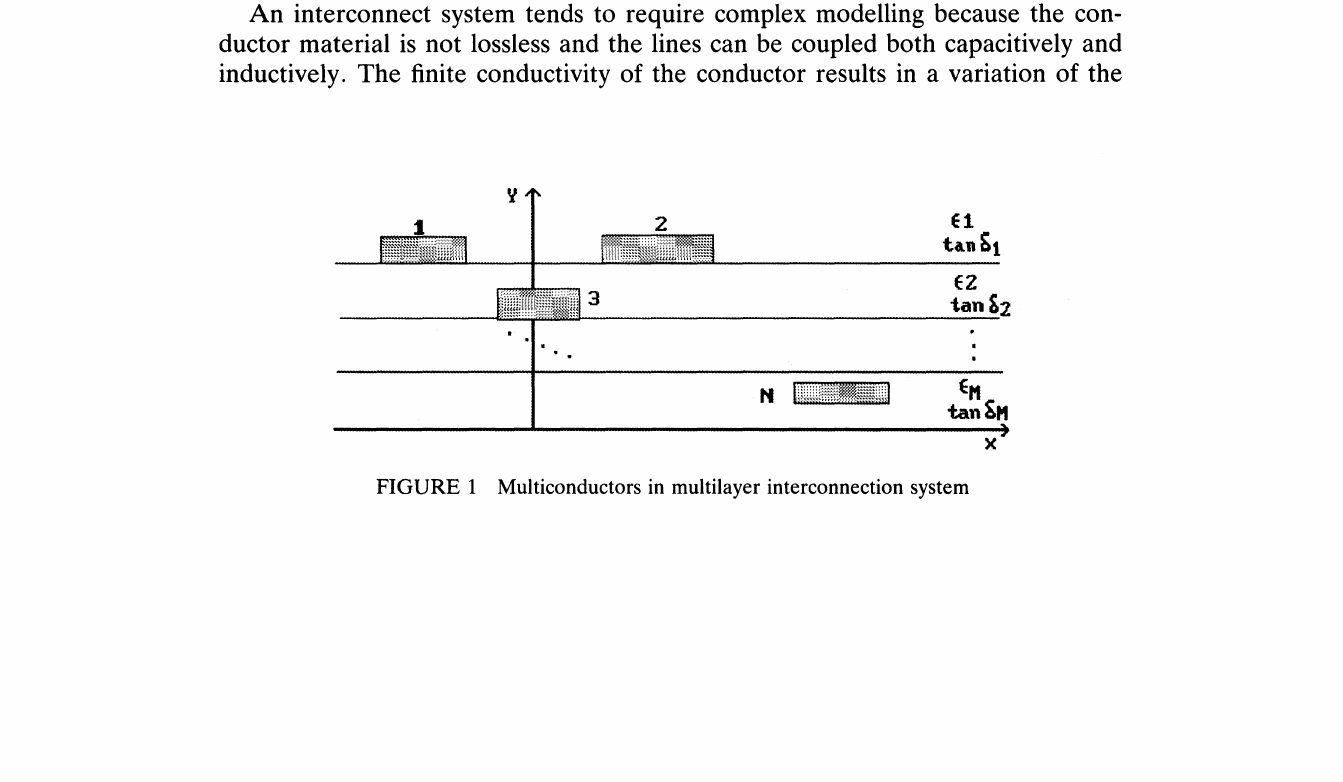
Multiconductors in multilayer interconnection